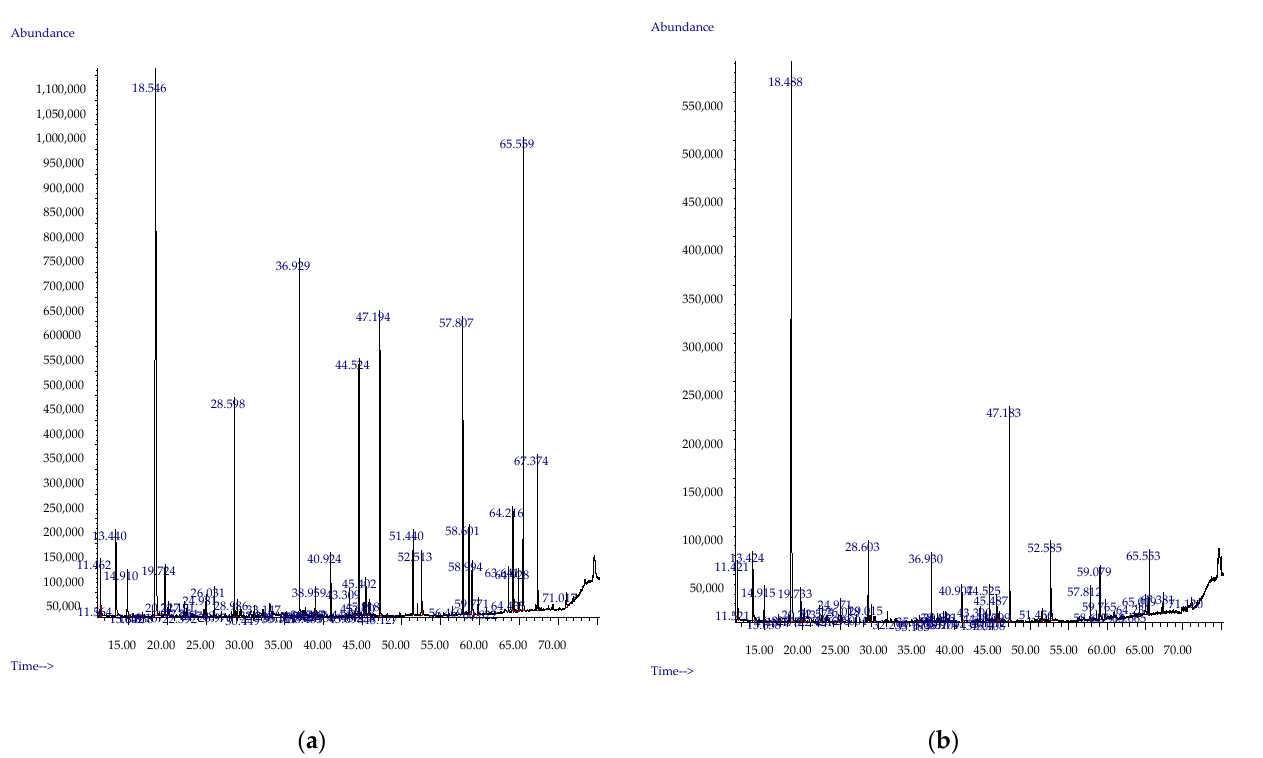
Figure 3. Chromatogram example for V1-I ( a ) vs. V6-I ( b ). V1—Endozym Thiol ® , AEB; V6—control sample, no enzymes; I—1st day of fermentation.